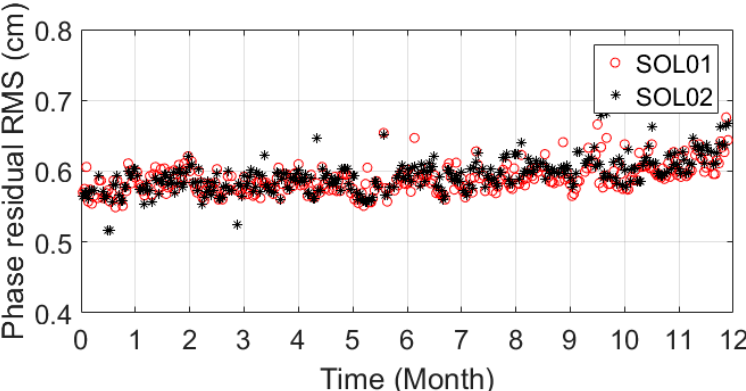
Figure 4. Daily RMS of GPS phase post-fit residuals of SOL01 and SOL02 in